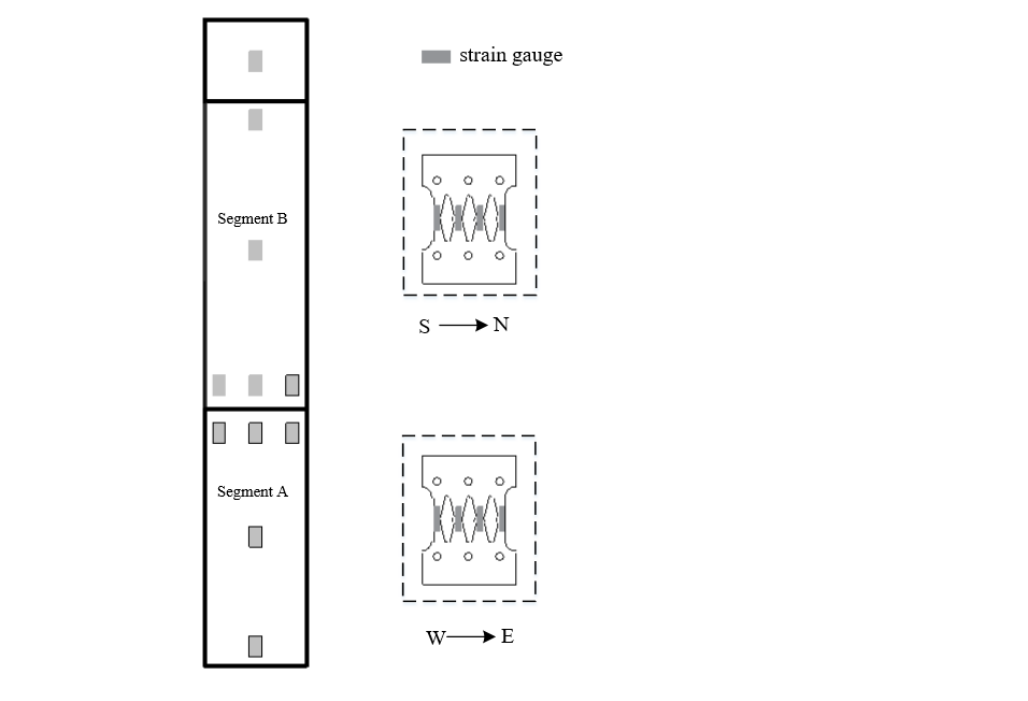
Figure 7. Strain gauge arrangement.